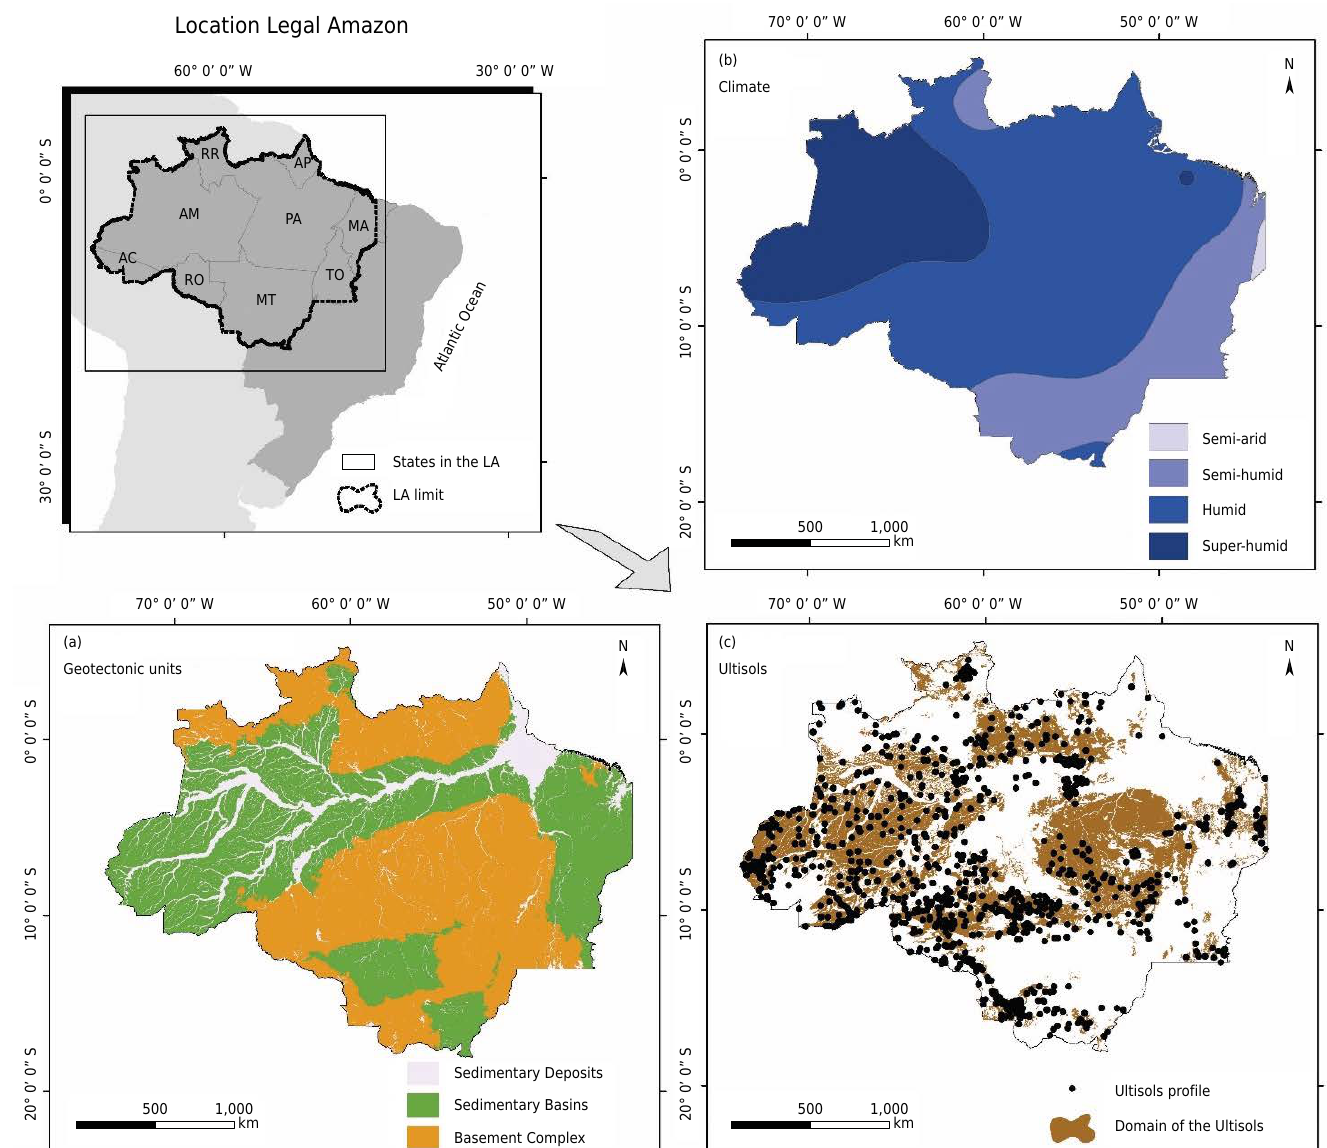
Figure 1. Location of the Legal Amazon with limits of the States, with an emphasis on morphostructural domains (a); climate zones (b), and profiles and domain of the Ultisols (c). Data (a) and (b) are available at IBGE